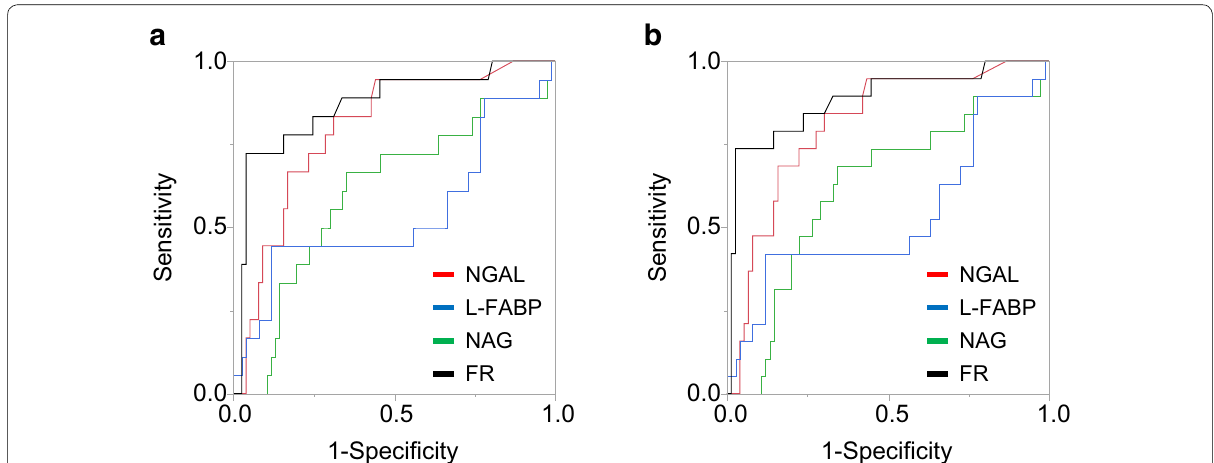
Fig. 3 Prediction of AKI progression by biomarkers and furosemide responsiveness (FR). Receiver operating characteristic curves (ROC) in a progres- sion to AKI stage 3 and b progression to AKI stage 3 or death at 1 week. NGAL, neutrophil gelatinase-associated lipocalin; L-FABP, L-type fatty acid binding protein; NAG, N -acetyl-β- d -glucosaminidase; FR, furosemide